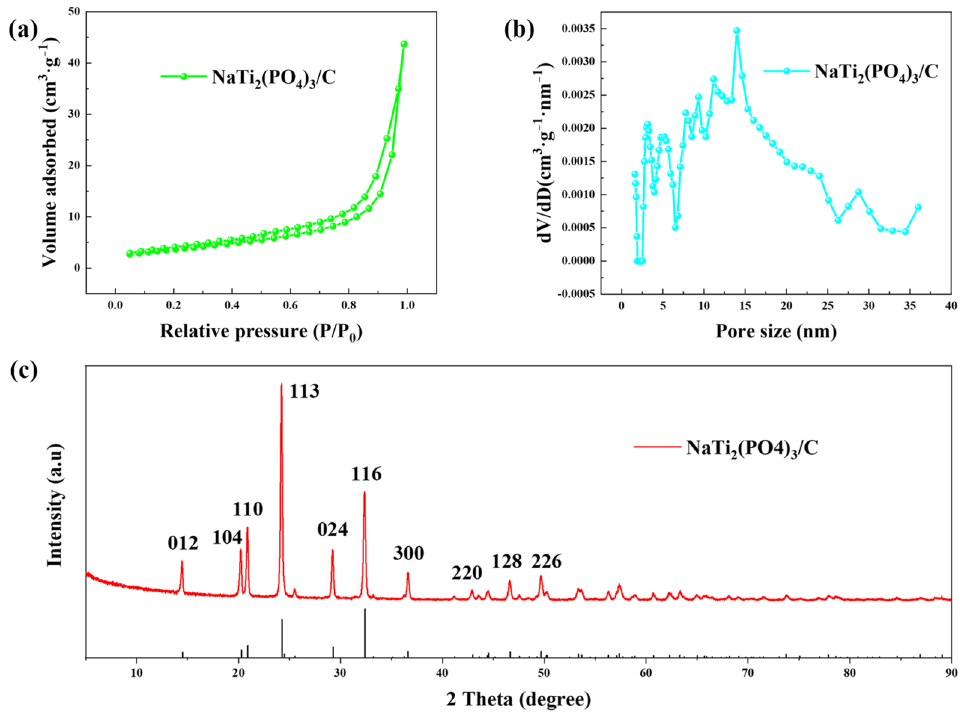
Figure 2. The ( a ) N 2 adsorption-desorption isotherm, ( b ) pore size distribution, and ( c ) XRD pattern of NaTi 2 (PO 4 ) 3 /C.